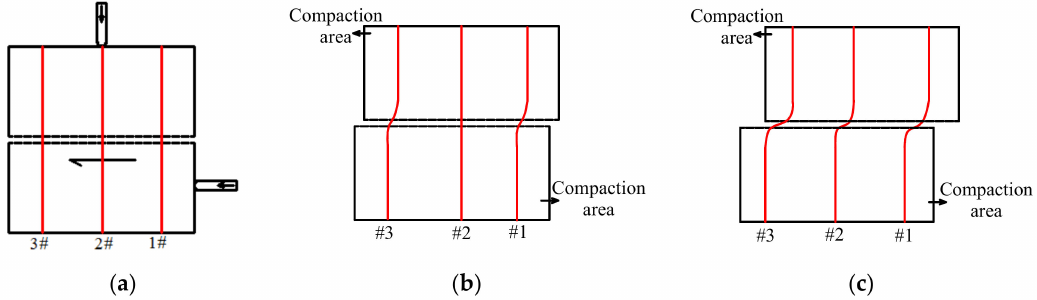
Figure 8. Schematic of the shearing process. ( a ) Beginning of shearing; ( b ) the early stage of shearing; ( c ) the late stage of shearing.